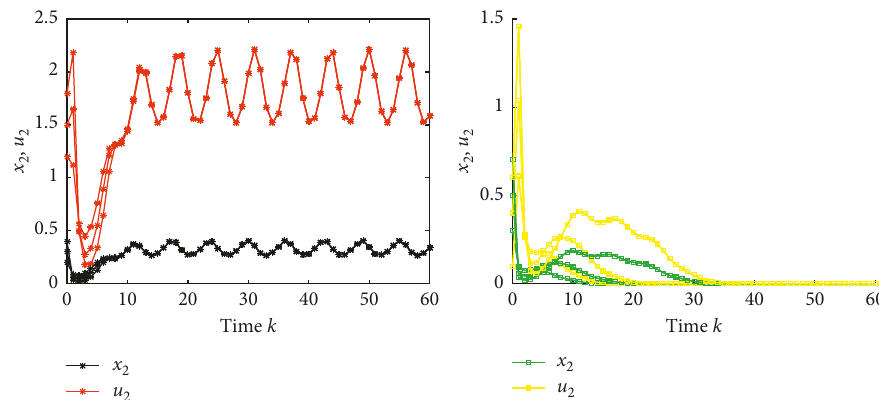
Figure 3: Numeric simulations of the solutions